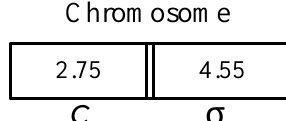
Figure 7. An example of a chromosome with real-valued coding of the membership function pa- rameters.